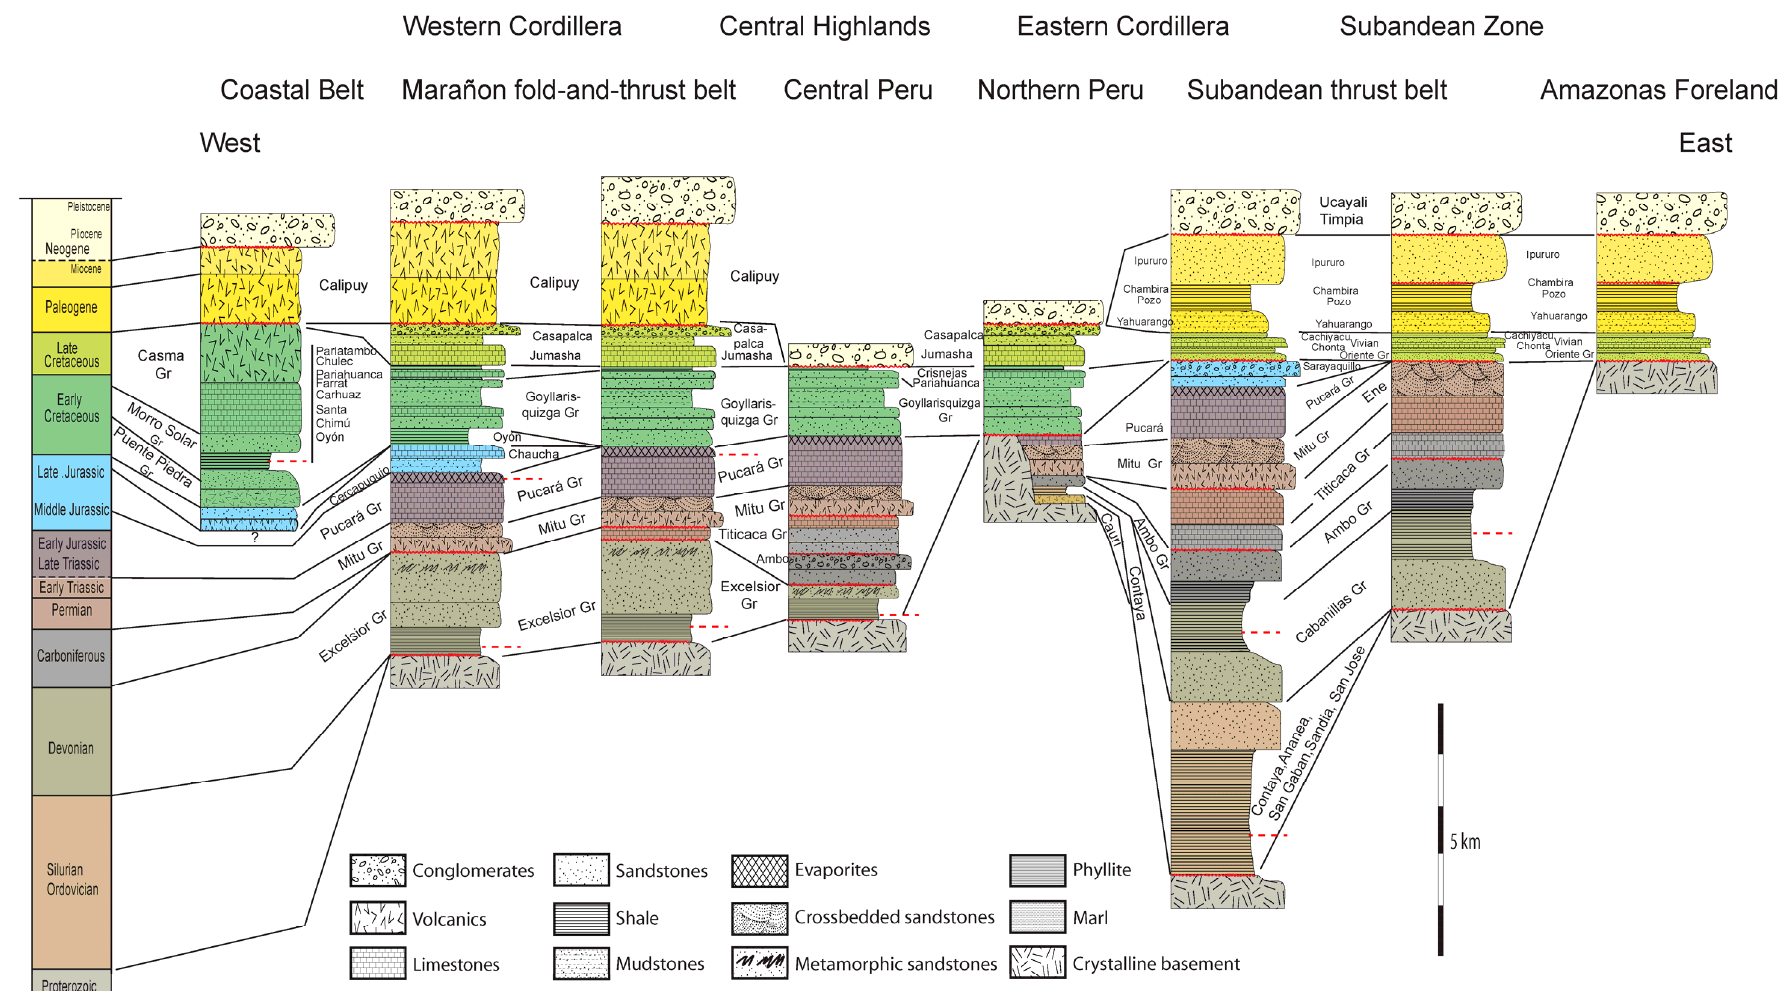
Figure 4. Stratigraphic framework of the Central Andes. The stratigraphic sequences and lateral variations are displayed by means of a set of carefully selected typical columns. See text for discussion and references used for this compilation. An enlarged version of this figure is available in the supplementary material (Figure